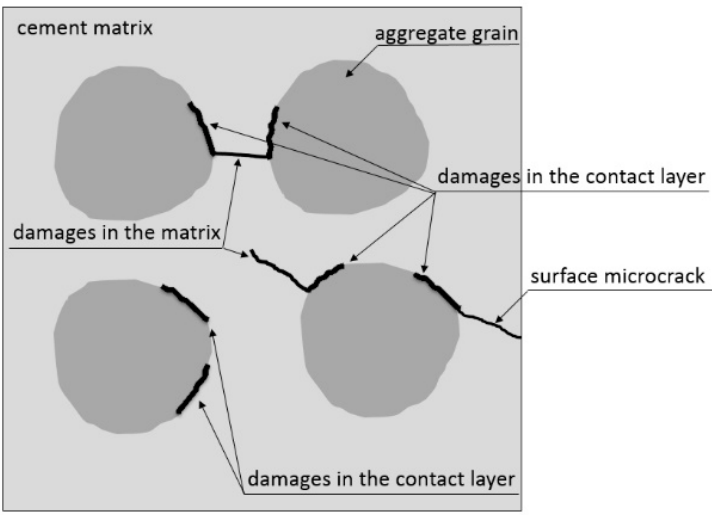
Figure 1. Examples of damages in the concrete microstructure, adapted from [6,7].